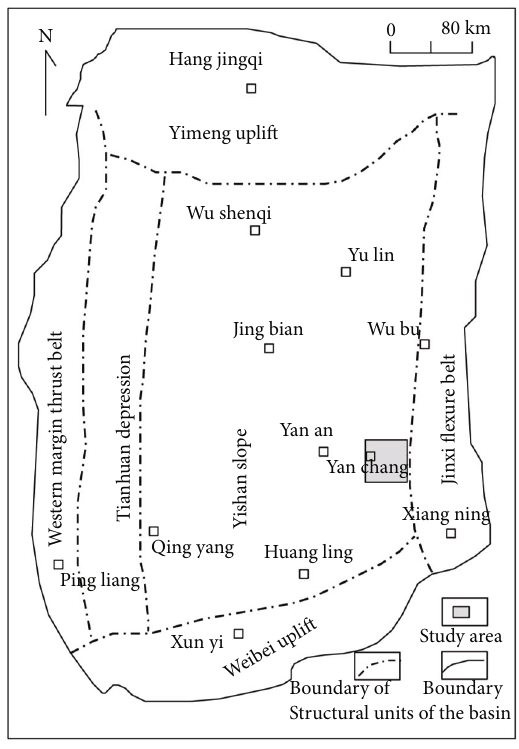
Figure 1: Structural location of Yanchang area in Ordos